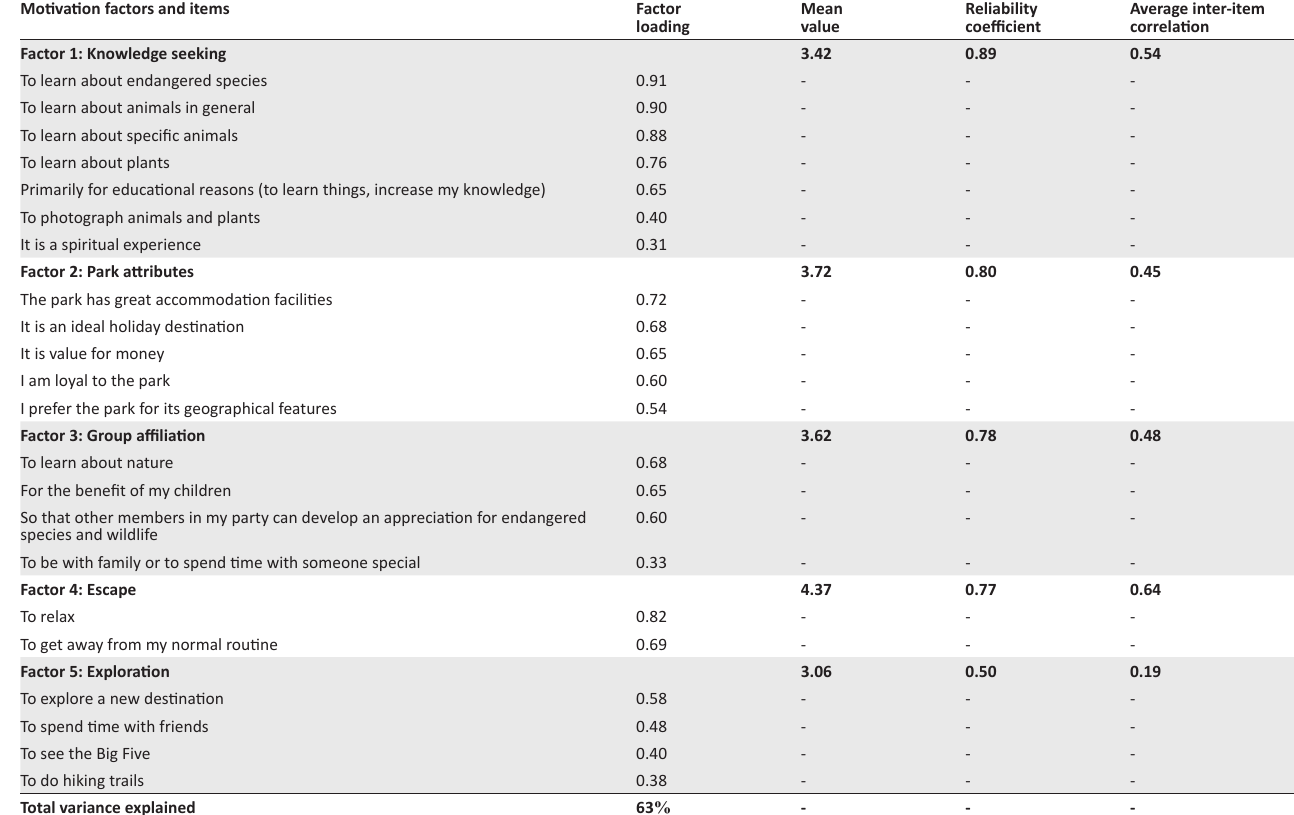
TABLE 2: Results of factor analysis of Kruger National Park visitor motives. Motivation factors and